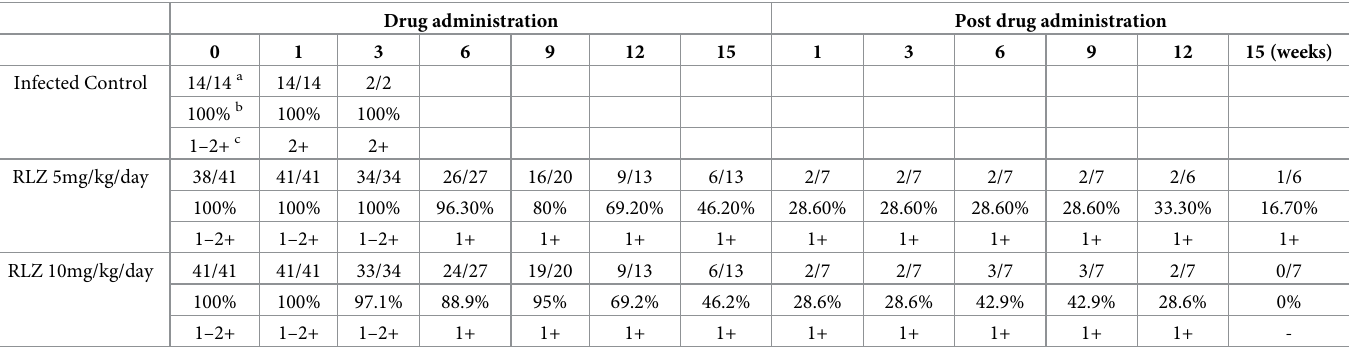
Table 1. Gross skin reddening of hind footpads in untreated and rifalazil-treated M . ulcerans infected